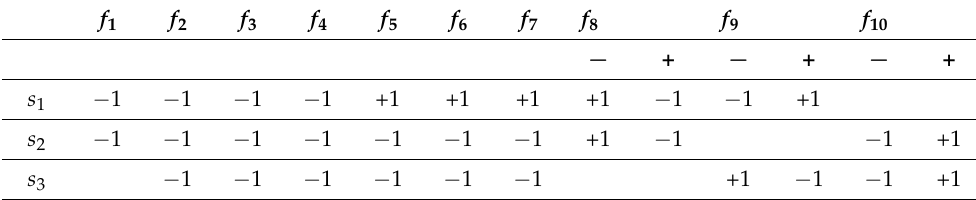
Table 7. Physically possible three-value fault signatures.